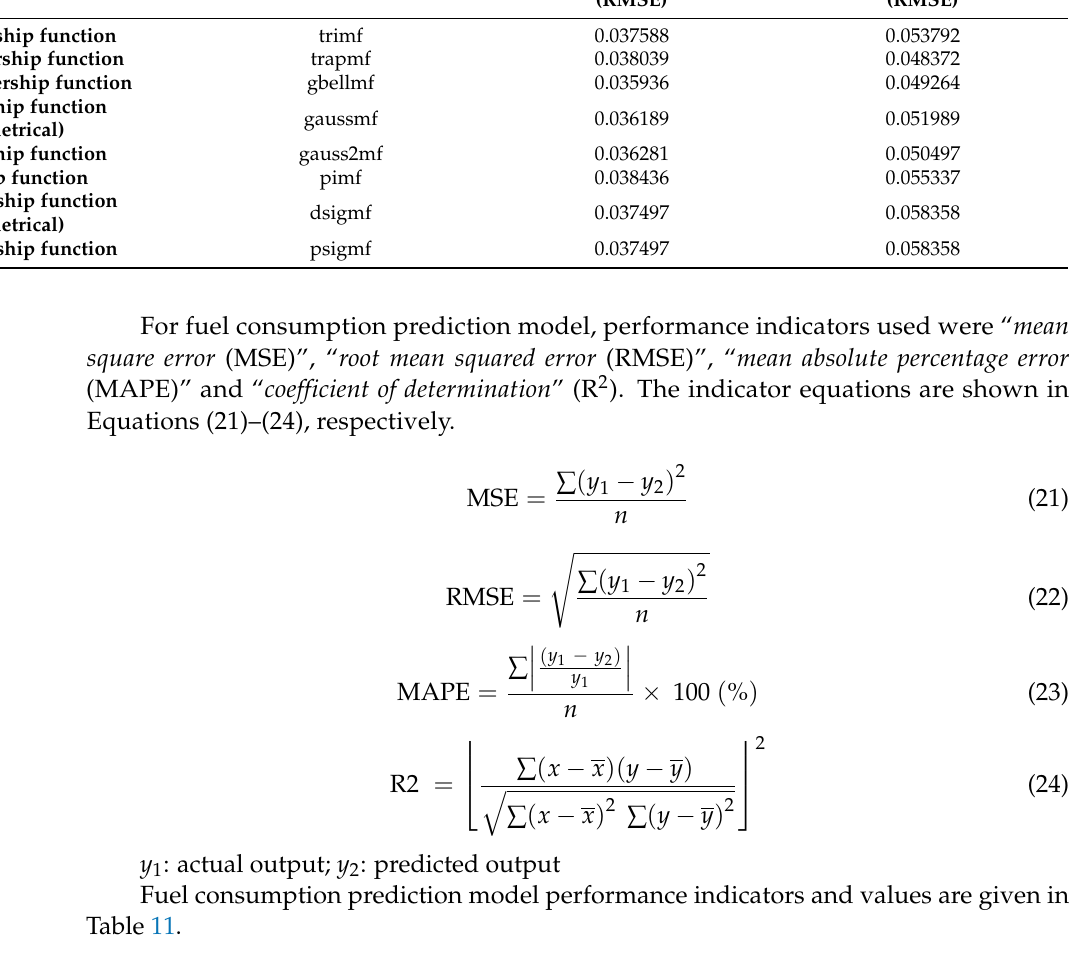
Table 10. The trapezoid membership function with the least test error was used for the fuel